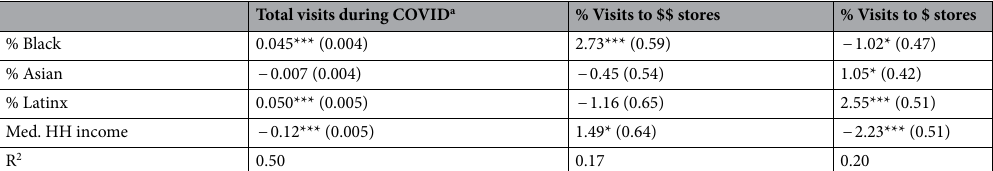
Table 2. Parameter estimates from regression models testing the relationship between race and socioeconomic status and patterns of grocery store visits in April 2020 relative to the same measures in February 2020. Sample of 2,363 CBGs in metro Boston, MA with population > 250 residents and values on all variables. All variables scaled before analysis, meaning parameters are an estimate of the increase or decrease with each change in 1 SD in the predictor variable. All models also controlled for the same measure in Feb. 2020, total population, population density, total stores or $$ or $ stores within a 15-min drive of the centroid of the CBG (as appropriate per model), % < 18 yrs., % > 65 yrs., and % commuting by car. See SI for all parameters. a Counts model only from a zero-inflated Poisson model. Zero-inflation model reported in SI. R 2 reported as McFadden’s pseudo- R 2